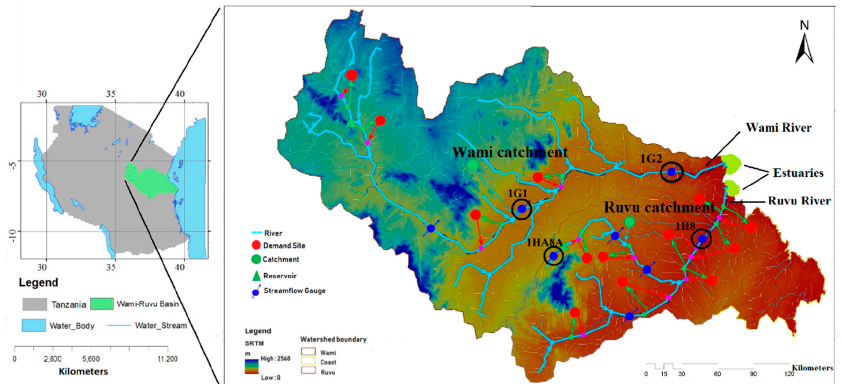
Figure 1. Map of the Wami Ruvu Basin located in Eastern Tanzania. Left : location of the basin; right : Water Evaluation and Planning system (WEAP) schematic diagram.